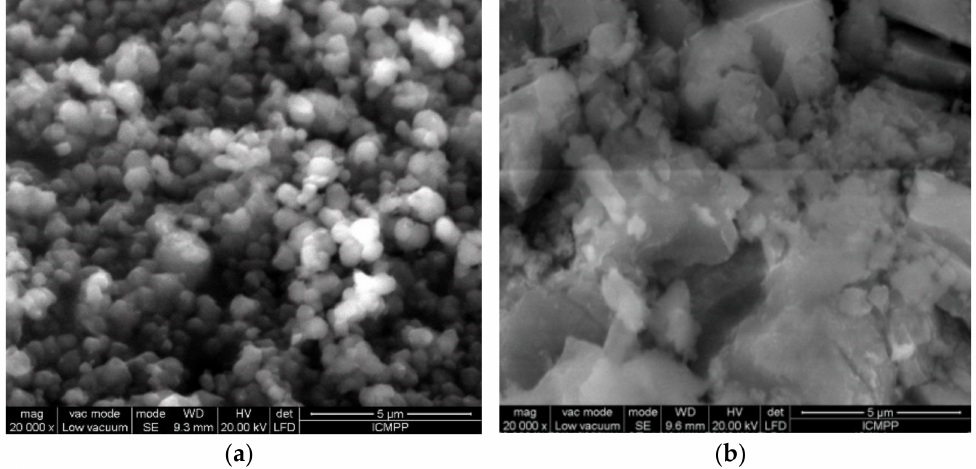
Figure 2. SEM microphotographs of ( a ) silica SBA-15 and ( b ) titanosilicate